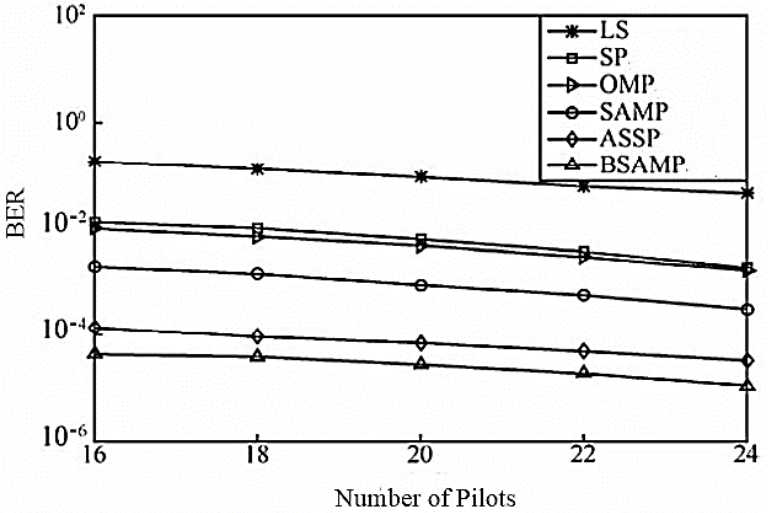
Figure 7. Comparison of BER of each algorithm under a different number of pilots.